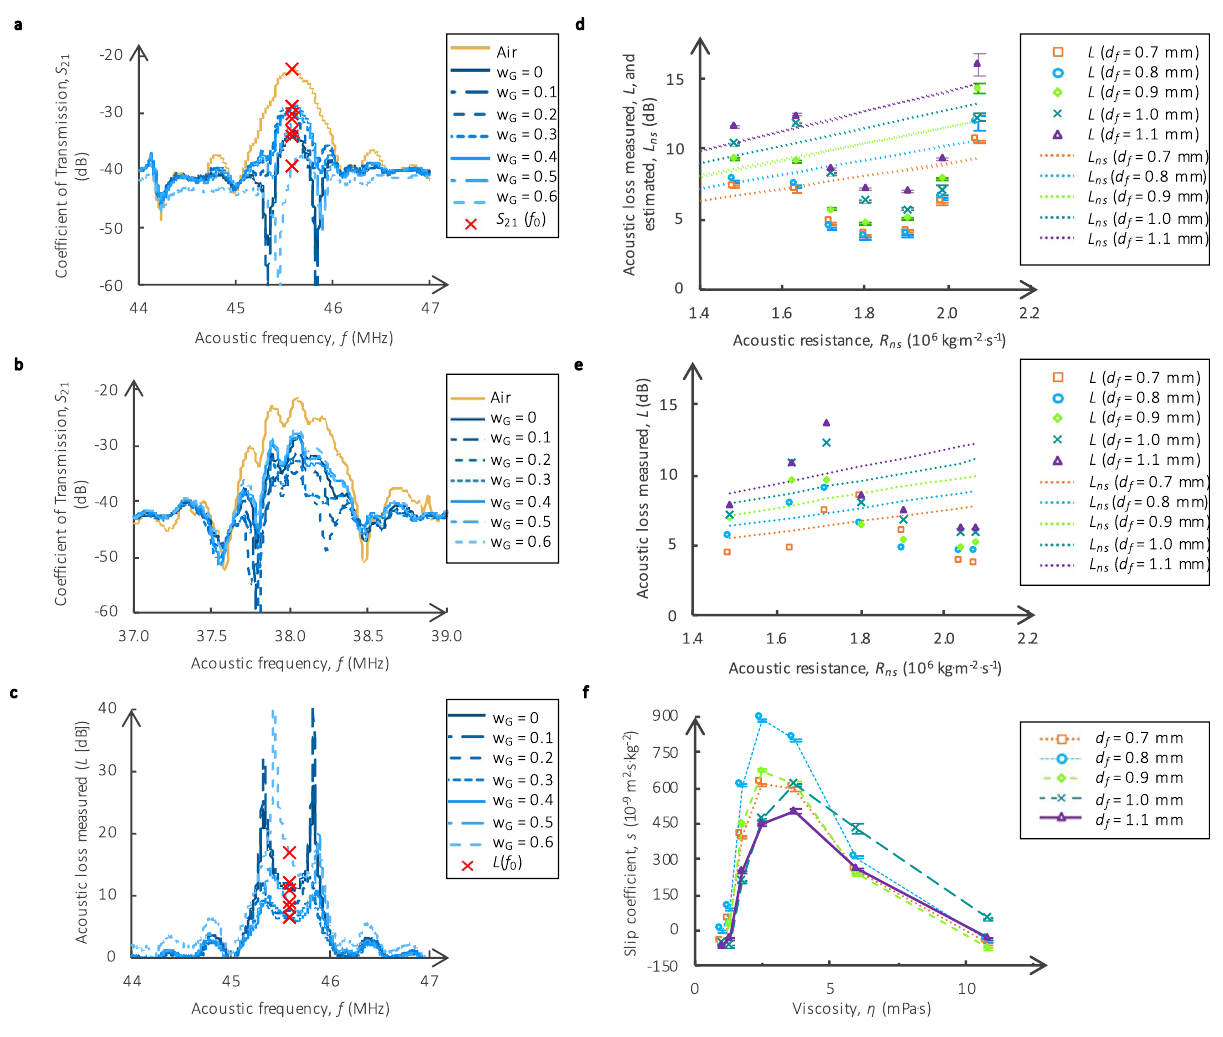
Fig. 2 Transmission scattering parameter, S21, and acoustic loss, L, measurements. a S 21 measurements for different solutions as a function of the acoustic wave frequency using sensor M 3 . The red x marker represents the S 21 value at 45.6 MHz. All S 21 values are expressed in decibels dB, with a drive power of 1 mW. b S 21 measurements for different solutions as a function of the acoustic wave frequency using sensor N 3 . c Experimental acoustic loss, L , of different solutions as a function of the acoustic wave frequency using sensor M 3 . The red x marker represents the L value at 45.6 MHz, which is the chosen frequency to study the impact of fl ow rate and viscosity on L . d Acoustic loss as a function of the acoustic resistance of the fl uids. L is plotted for the fi ve sensors ( M 1 to M 5 ) with different d f (0.7 – 1.1 mm). The expected acoustic loss without slip, L ns , for each d f is also represented with dashed lines. Since L